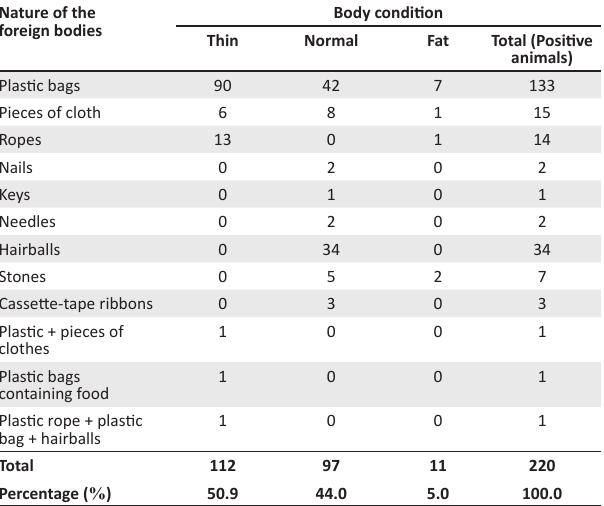
TABLE 7: Prevalence of the foreign bodies according to their type and the body condition score.